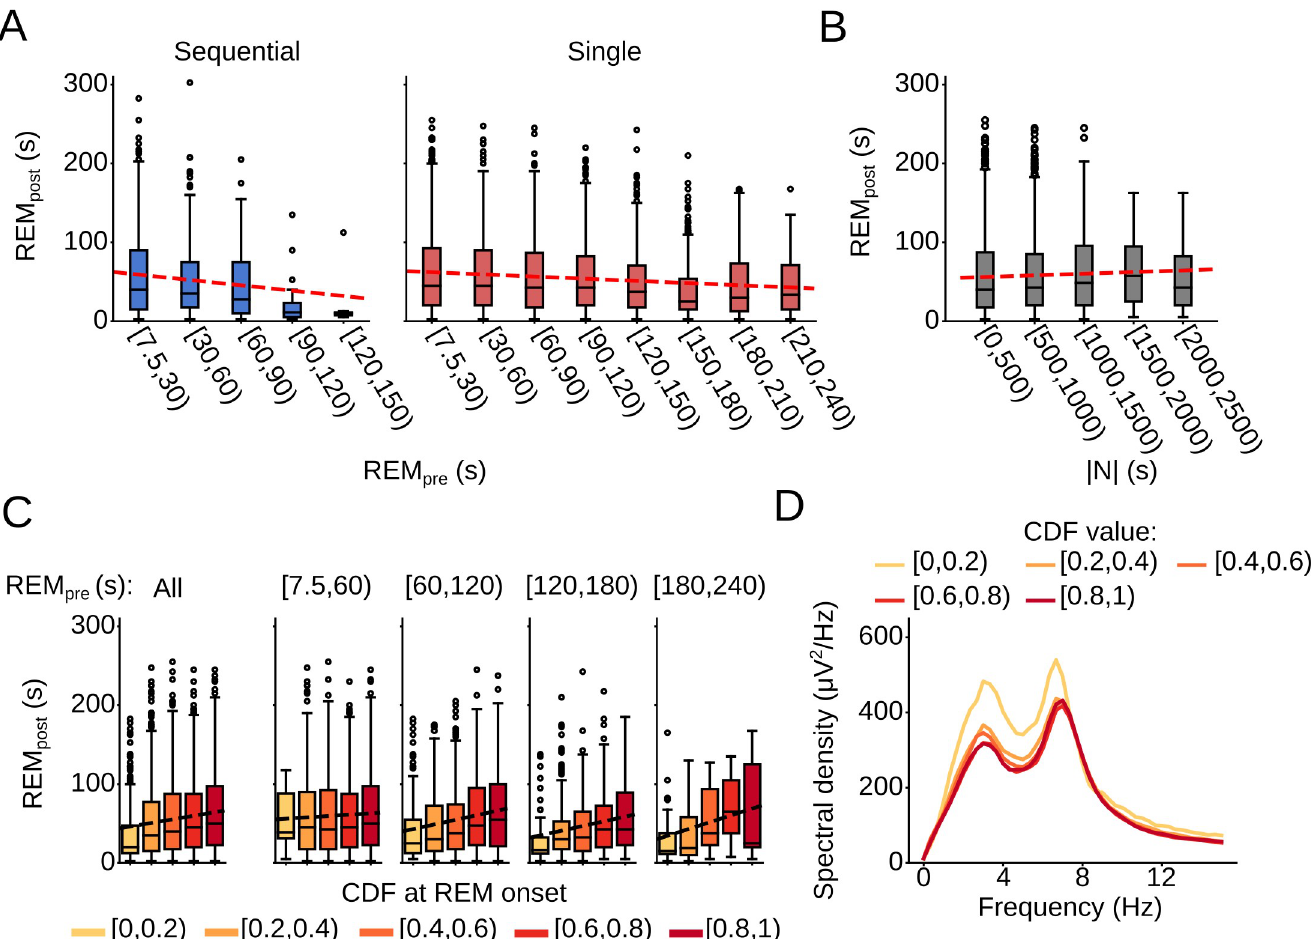
Fig 6. Effects of sleep history on REM episode duration. (A) (Left) Box plot comparing the duration of REM sleep (REM post ) following sequential cycles for different values of REM pre . Red line, linear regression (slope = -0.22, R 2 = 0.010, p = 0.0020). (Right) Box plot comparing REM post following single cycles for different values of REM pre . Red line, linear regression (slope = -0.091, R 2 = 0.0089, p = 5.07e-09). (B) Box plot comparing REM post following single cycles with different values of |N|. Red line, linear regression (slope = 0.0041, R 2 = 9.83e-04, p = 0.052). (C) Box plots comparing REM post dependent on the CDF value at REM onset for single cycles. The left plot includes all REM pre values; the remaining plots show the correlation for increasing ranges of REM pre . Dashed lines, linear regression (All: slope = 22.82, R 2 = 0.013, p = 1.01e-12; [7.5,60): slope = 8.58, R 2 = 0.0013, p = 0.090; [60,120): slope = 29.42, R 2 = 0.024, p = 1.57e-07; [120,180): slope = 29.64, R 2 = 0.039, p = 3.12e-06; [180,240): slope = 43.28, R 2 = 0.077, p = 0.0060). (D) Spectral density of prefrontal EEG during REM episodes following single cycles as a function of the CDF at REM onset (Welch’s ANOVA, δ : F(4,1078.85) = 16.18, p = 7.04e-13; θ : F(4,1084.95) = 6.06, p = 8.0e-05; σ : F(4,1089.74) = 9.46, p =